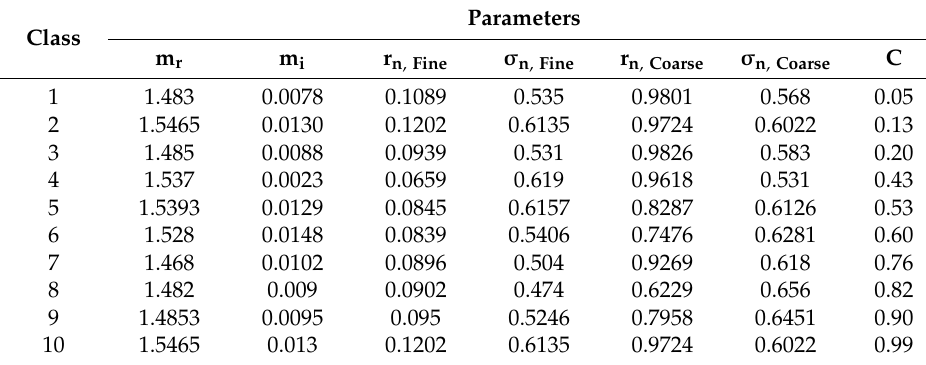
Table A1. The parameters for the aerosol models used in this study [8,26,27]. m r is the real part of the complex refractive index, m i is the imaginary part of the complex refractive index, Fine and Coarse refer to the fine- and coarse-mode, respectively, and C is the percentage density of fine particles by